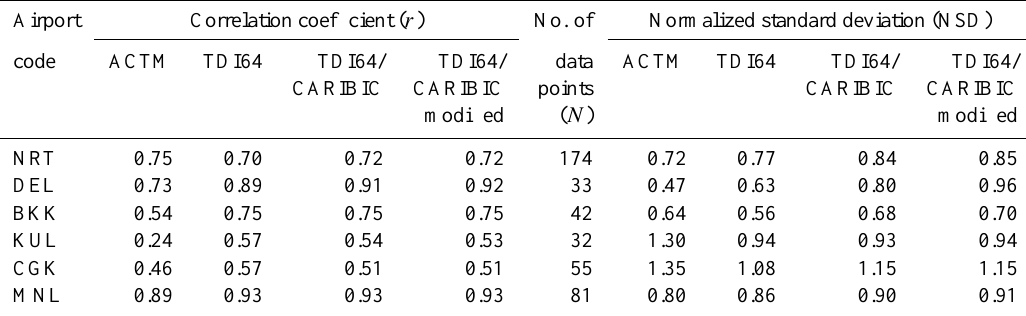
Table 1. Statistics ( r and NSD) showing overall performance of ACTM simulations in comparison with CONTRAIL measurements at upper tropospheric altitudes (300–200mb) around 6 airport sites (ref. Fig. 6a–f). The r values greater than 0.45 are statistically significant at 99% confidence interval in student’s-T two-tailed test for 30 data points. Although r did not increase for TDI64/CARIBIC compared to TDI64, the NSDs improved for NRT, BKK and MNL. No overall difference is noted for KUL and CGK where results appeared best for TDI64. The ACTM simulation using TDI64/CARIBIC-modified flux produced excellent agreement with the CONTRAIL CO 2 seasonal cycle.